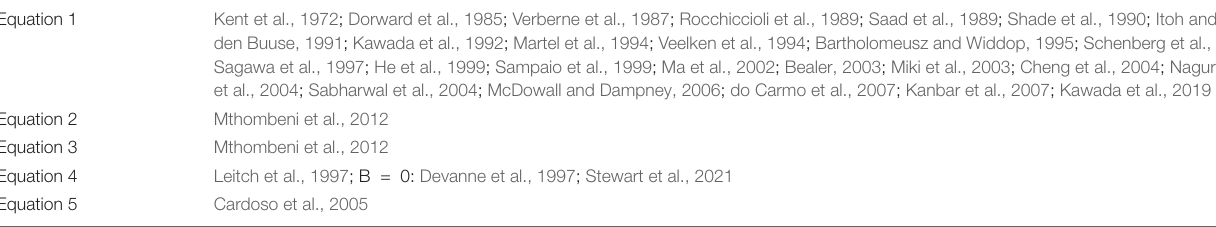
TABLE 2 | Selected references referring to variants of the 4-parameter Boltzmann sigmoidal